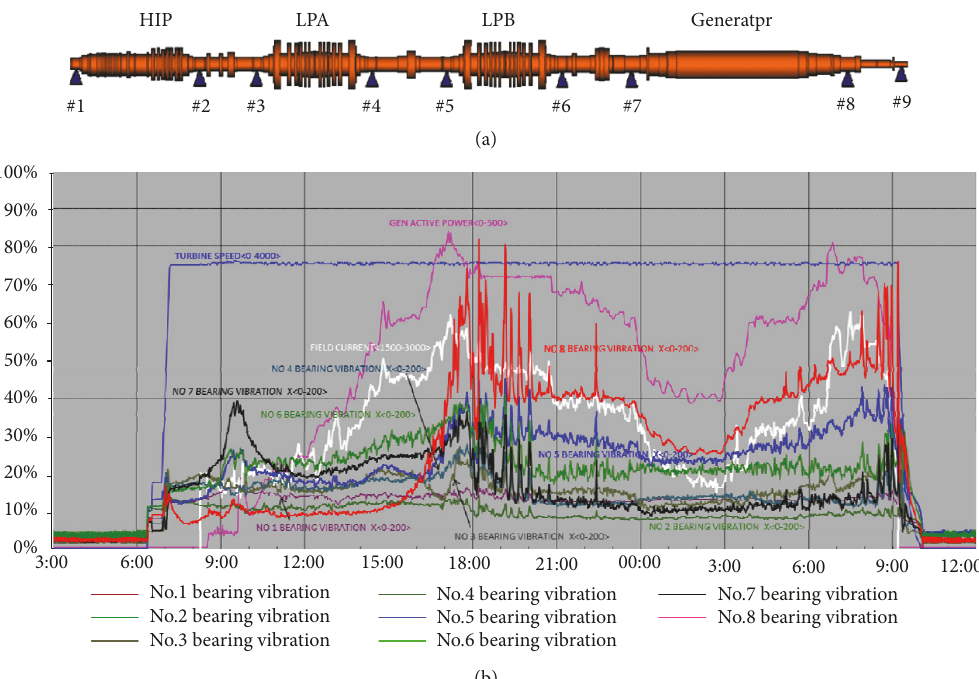
Figure 1: The first unit turbine of Vungang I: (a) Rotor shaft system of turbine generator rotor. (b) Operation data record on 24th to 25th, Nov.